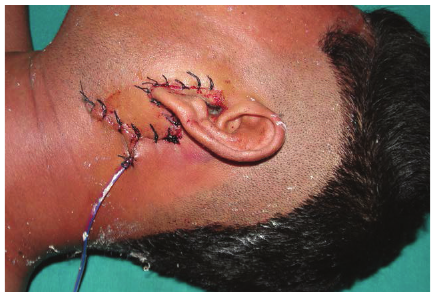
Figure 10: Photograph of the surgical area on the 1st postoperative